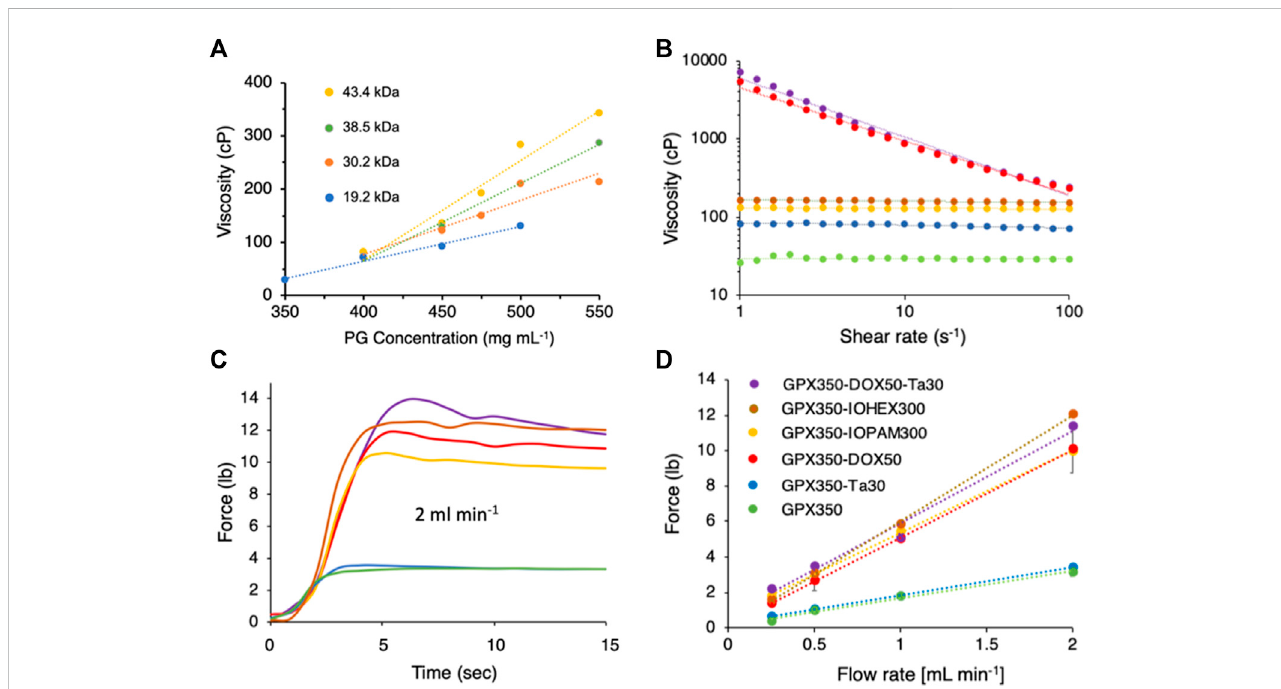
FIGURE 3 (A) GPX viscosity as a function of polyguanidium (PG) MW and concentration. Dotted lines are linear fi ts to the data points. (B) Flow curves of fi ve GPX formulations. The colors and symbols corresponding to the formulations are shown in panel D. Data points represent the mean of three measurements. Dotted lines are linear fi ts to the data points. Error bars were omitted for clarity. (C) . Representative time courses of injection forces required for each formulation injected through a 120 cm, .025 ″ ID microcatheter at 2 mL min − 1 . (D) . Injection force as a function of fl ow rate. Data points represent the mean of three measurements. Error bars represent ± 1